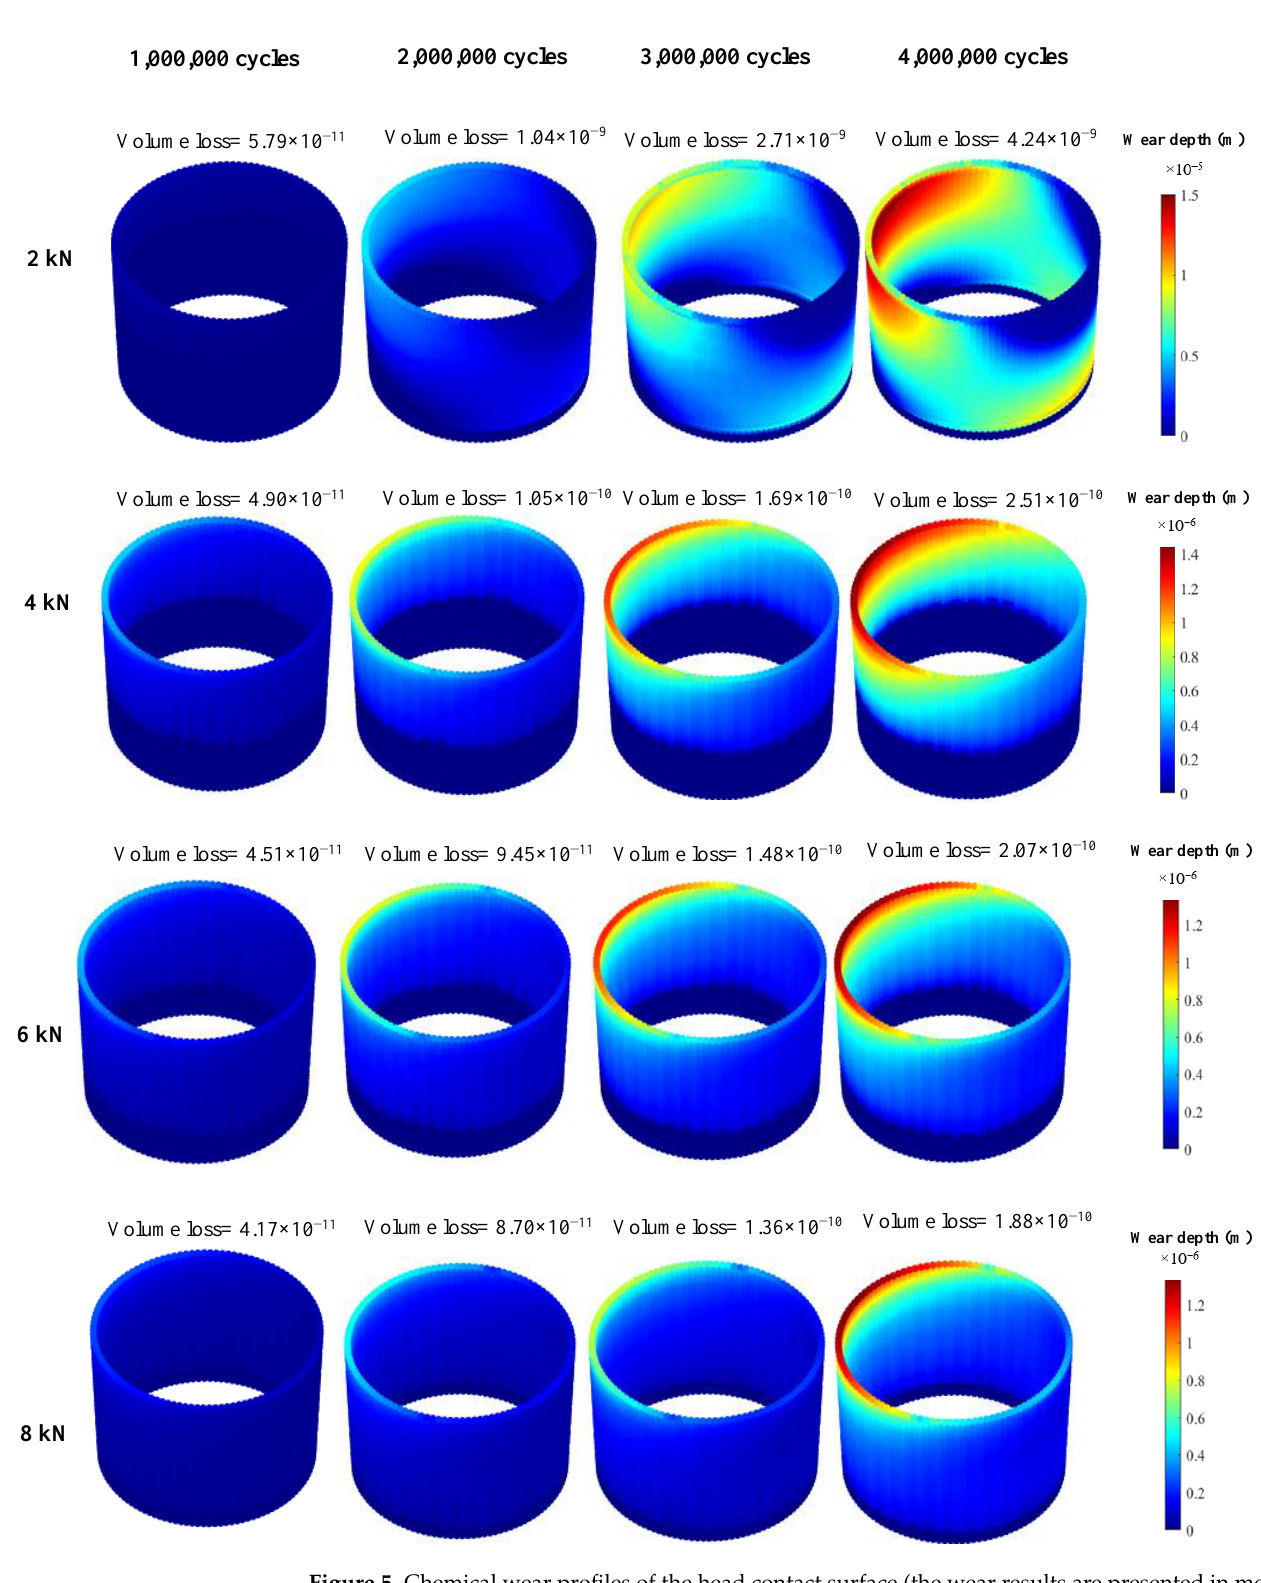
Figure 5. Chemical wear profiles of the head contact surface (the wear results are presented in meter and the volume losses are in m 3 ).